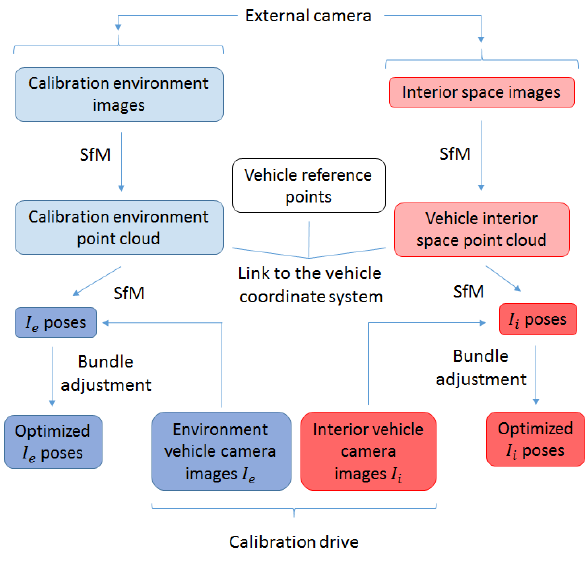
Figure 2: Process workflow to estimate the poses of vehicle envi- ronment I e and vehicle interior cameras I i with non-overlapping fields-of-view in an urban